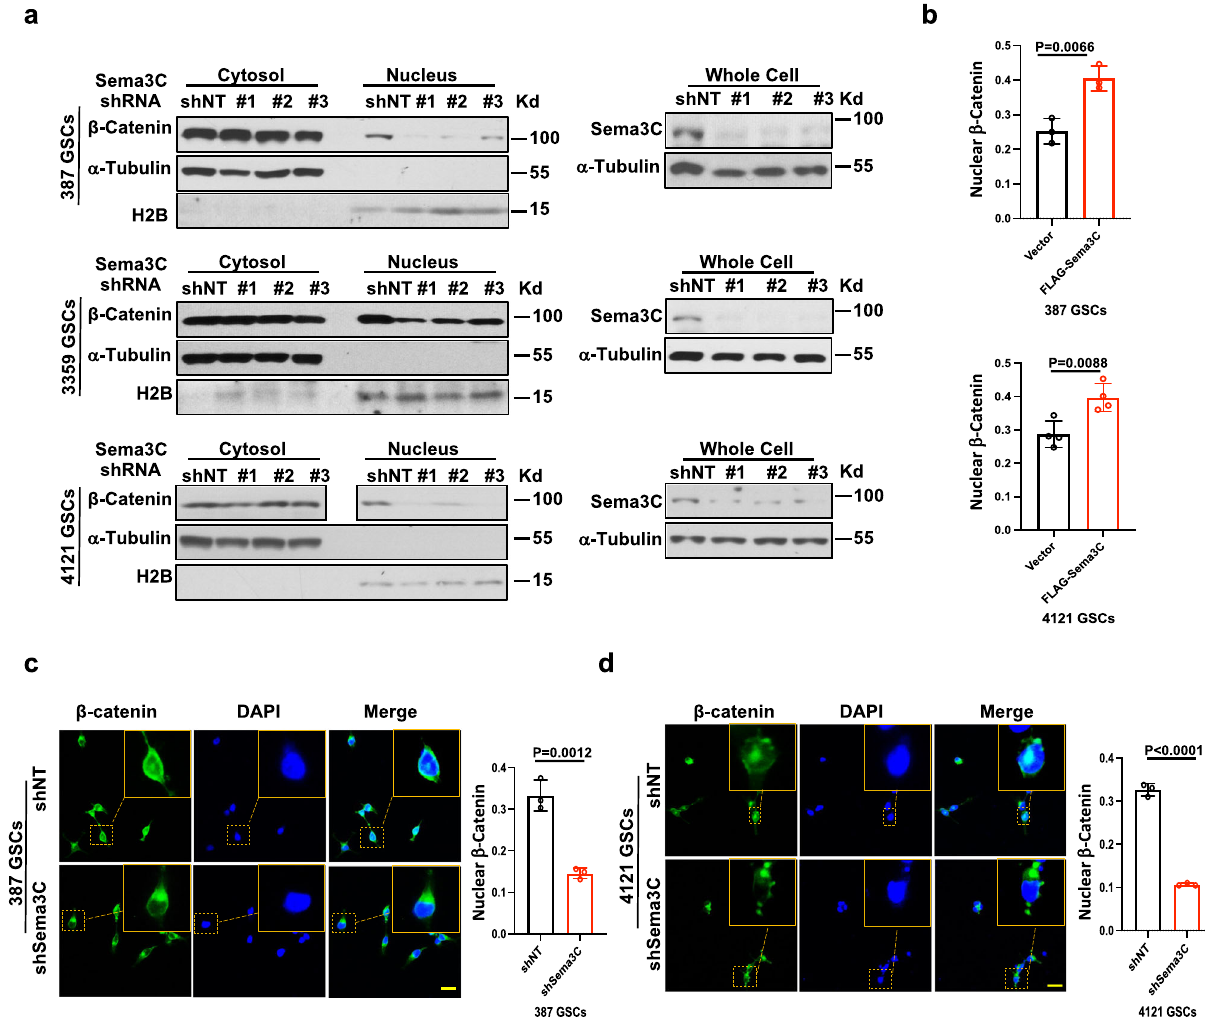
Fig. 4 | Sema3C promotes β -catenin nuclear localization. a Western blots of β - catenin in cytosolic and nuclear fractions (left) of GSCs after Sema3C knockdown (right). Western blots were repeated at least twice. b Quanti fi cation of nuclear β